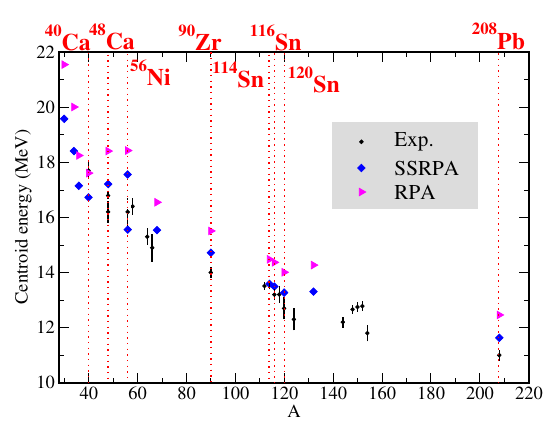
Figure 4. Centroids of the isoscalar GQR: the experimental data in black circles are compared with the SSRPA (RPA) predictions are plotted as blue diamonds (magenta triangles).